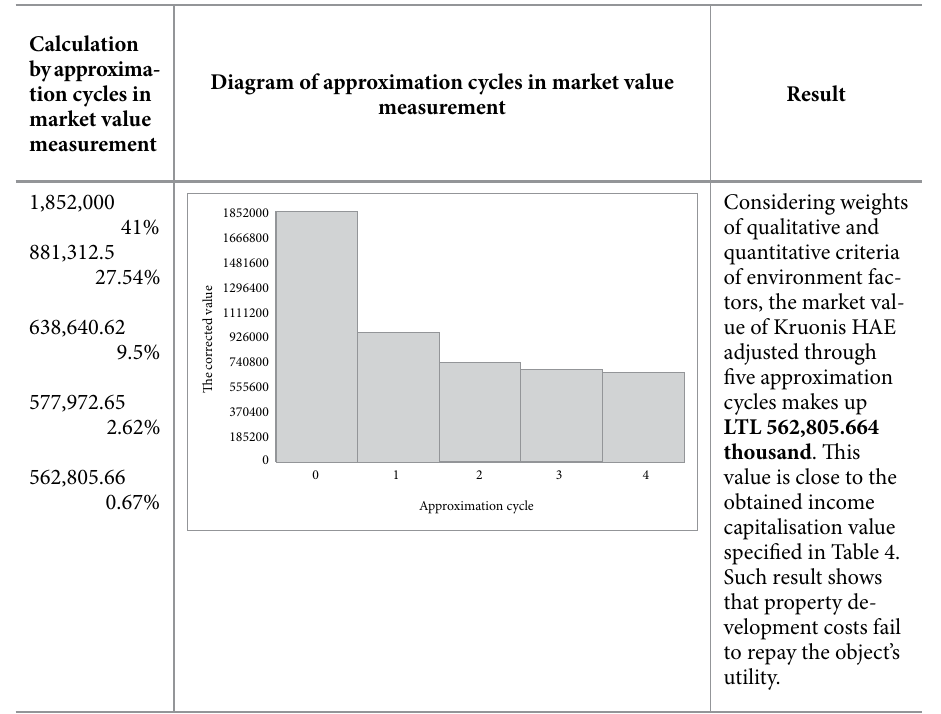
table 7. The result of market value measurement for Kruonis Pumped-storage Hydroelectric Power Plant calculation by approxima­ diagram of approximation cycles in market value tion cycles in measurement market value measurement